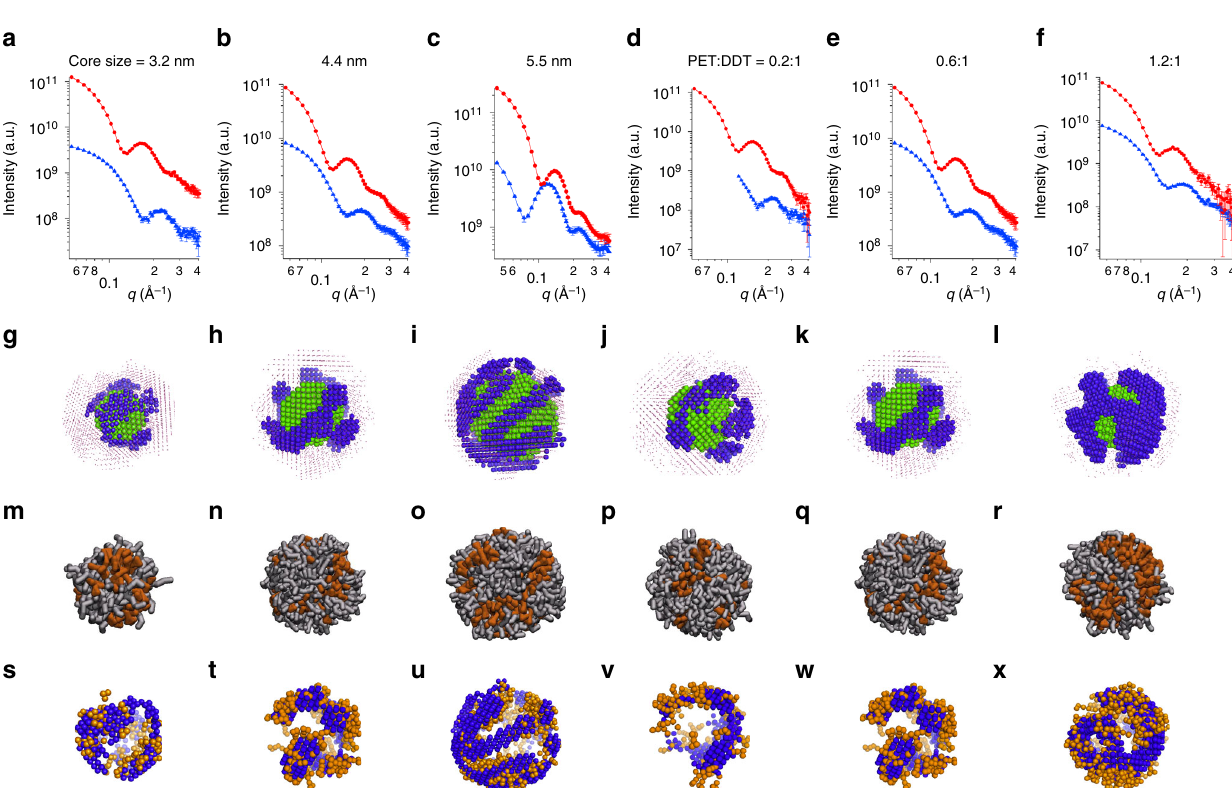
Fig. 3 SANS and simulation study of various PET-DDT nanoparticles . In SANS data, red dots and curves represent the data and fi ts of dPET-DDT particles, while blue ones represent that of PET-dDDT particles. All the solvents are deuterated toluene. The only exception is in the 5.5 nm nanoparticles where the blue curve represents dPET-DDT in deuterated chloroform. The fi ts are from MONSA fi tting and correspond to the theoretical scattering curves of each model. In simulation models, gray sticks represent DDT ligands, while orange sticks represent PET ligands. Panels a – c compare same ligand ratio but different core-sized AuNPs: a SANS data and fi ts (with a fi nal χ 2 value of the model fi tting of 1.52), g model, and m mesoscale morphology of 3.2 nm particle. b SANS data and fi ts (with a fi nal χ 2 value of the model fi tting of 0.79), h model, and n mesoscale morphology of 4.4 nm particle. c SANS data and fi ts (with a fi nal χ 2 value of the model fi tting of 1.01), i model, and o mesoscale morphology of 5.5 nm particle. Panels d – f compare AuNPs with same 4.4 nm core size but with different ligand ratios: d SANS data and fi ts (with a fi nal χ 2 value of the model fi tting of 0.94), j model, and p mesoscale morphology of PET:DDT = 0.2:1 particle. e SANS data and fi ts (with a fi nal χ 2 value of the model fi tting of 0.71), k model, and q mesoscale morphology of PET:DDT = 0.6:1 particle. f SANS data and fi ts (with a fi nal χ 2 value of the model fi tting of 0.71), l model, and r mesoscale morphology of PET:DDT = 1.2:1 particle. 3D overlapping comparisons of the PET phase of SANS and simulation model, generated using SUPCOMB program are in s – x . The error bars in the SANS data represent standard deviations of neutron counts and are explained in detail in Method